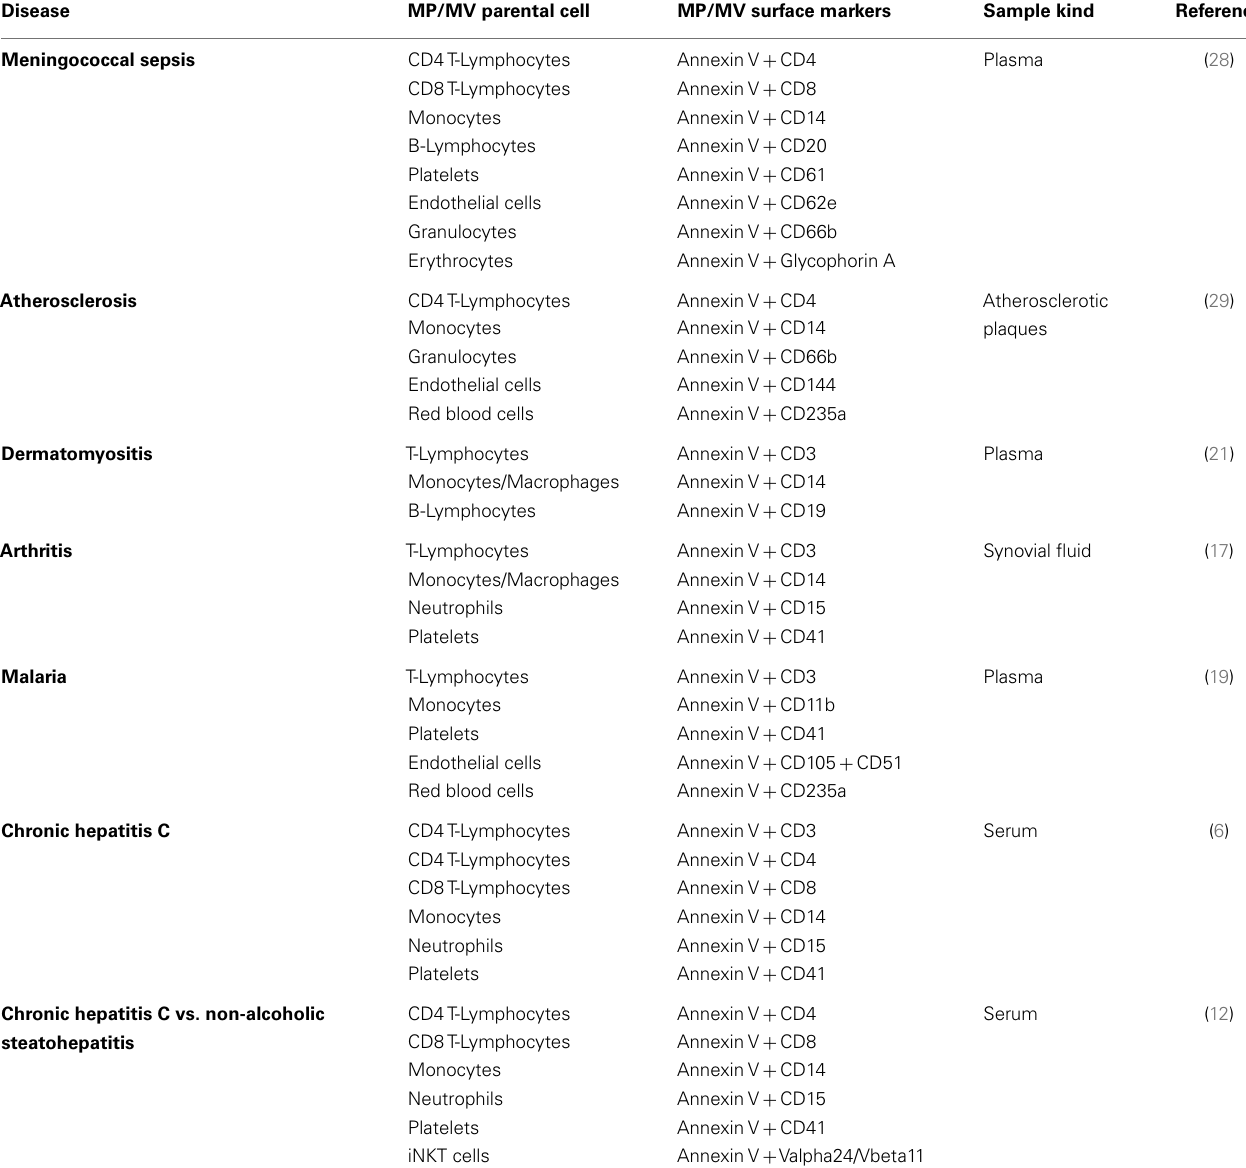
Table 1 | Summary of the MP/MV profiles of indicated diseases and used surface MP/MV markers .